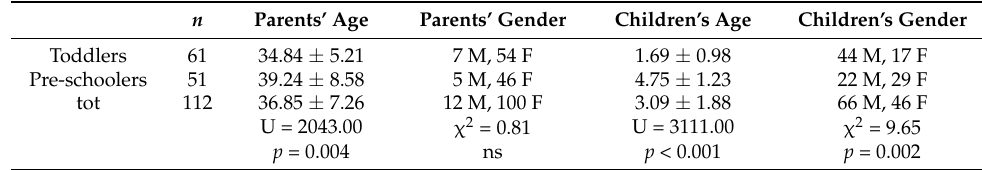
Table 1. Demographic characteristics of the sample and their differences between groups.